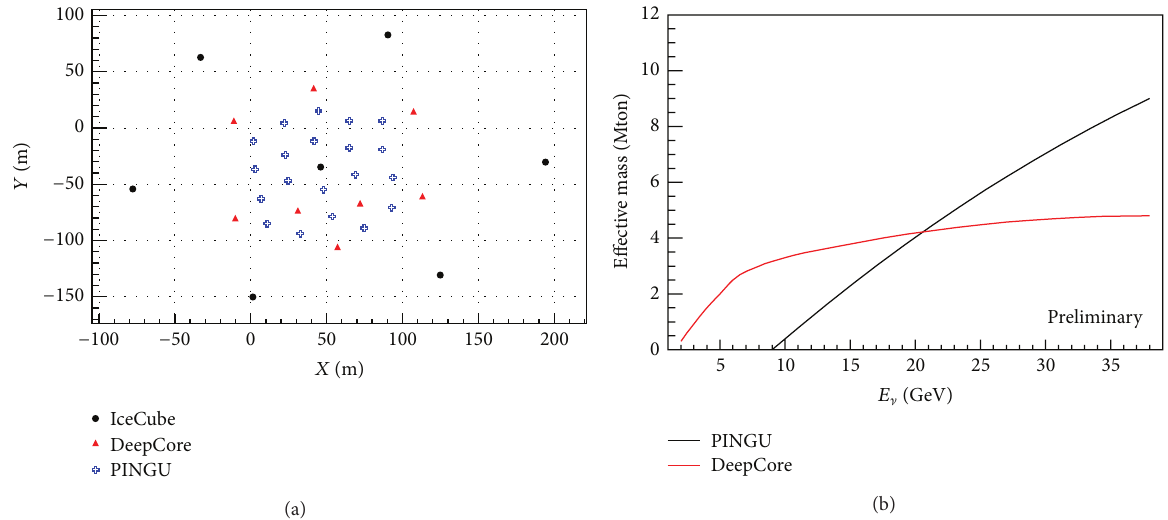
Figure 8: (a) Overhead view of the PINGU geometry layout with 20 additional detector strings. (b) Effective volume for PINGU in the baseline configuration (20 strings) in comparison with DeepCore. A fiducial volume defined by a cylinder with radius of 75 m and a height of 332 m is assumed. A threshold of 20 hits per event was assumed (figure from